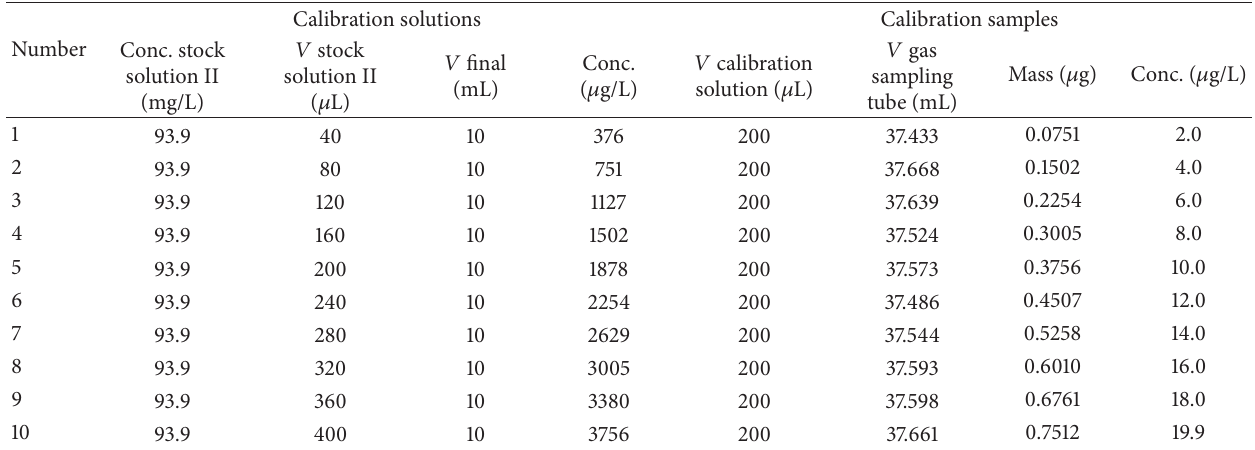
Table 1: Example pipetting scheme for the preparation of the calibration samples; concentration range 2 to 20 𝜇 g tetrachloroethene/L exhaled